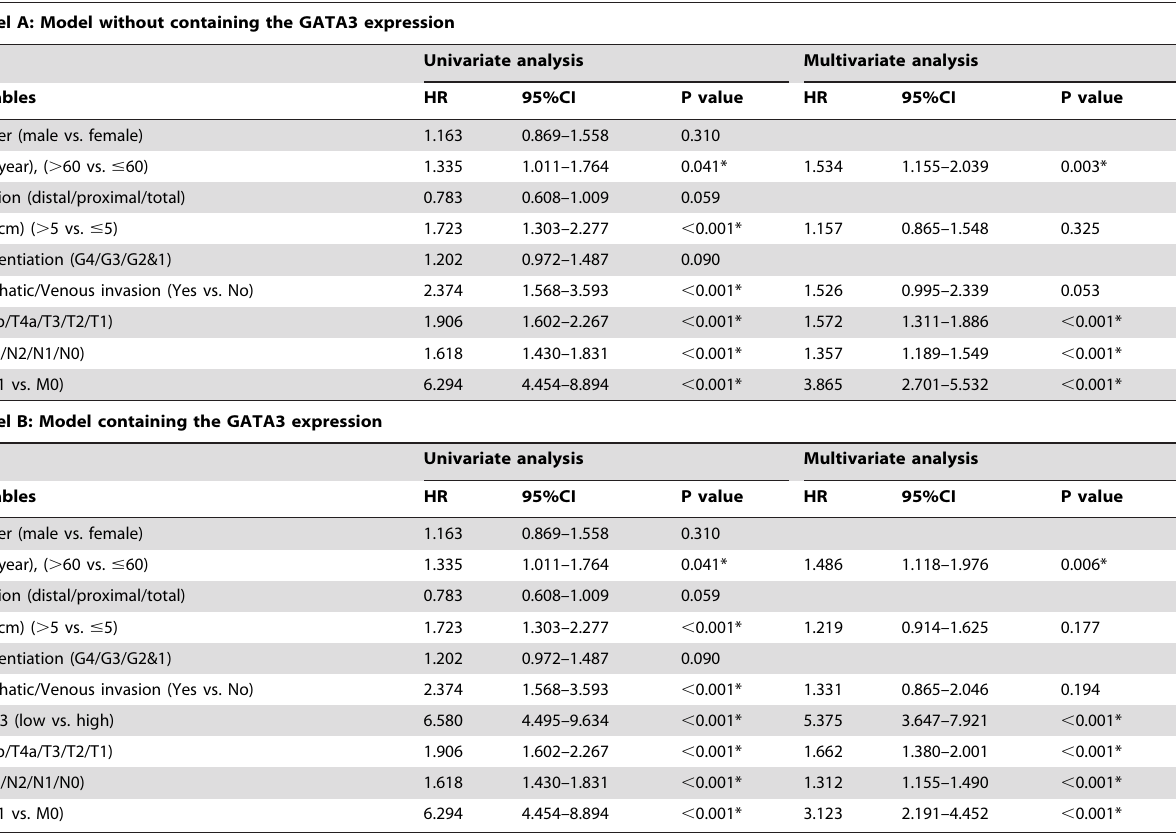
Table 2. Univariate and multivariate survival analysis of clinic-pathologic variables in 402 cases of gastric carcinoma patients.